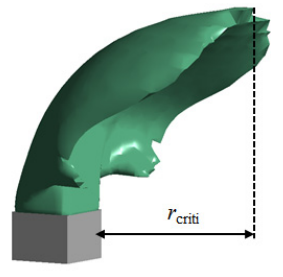
Figure 18. Diagram of r criti .